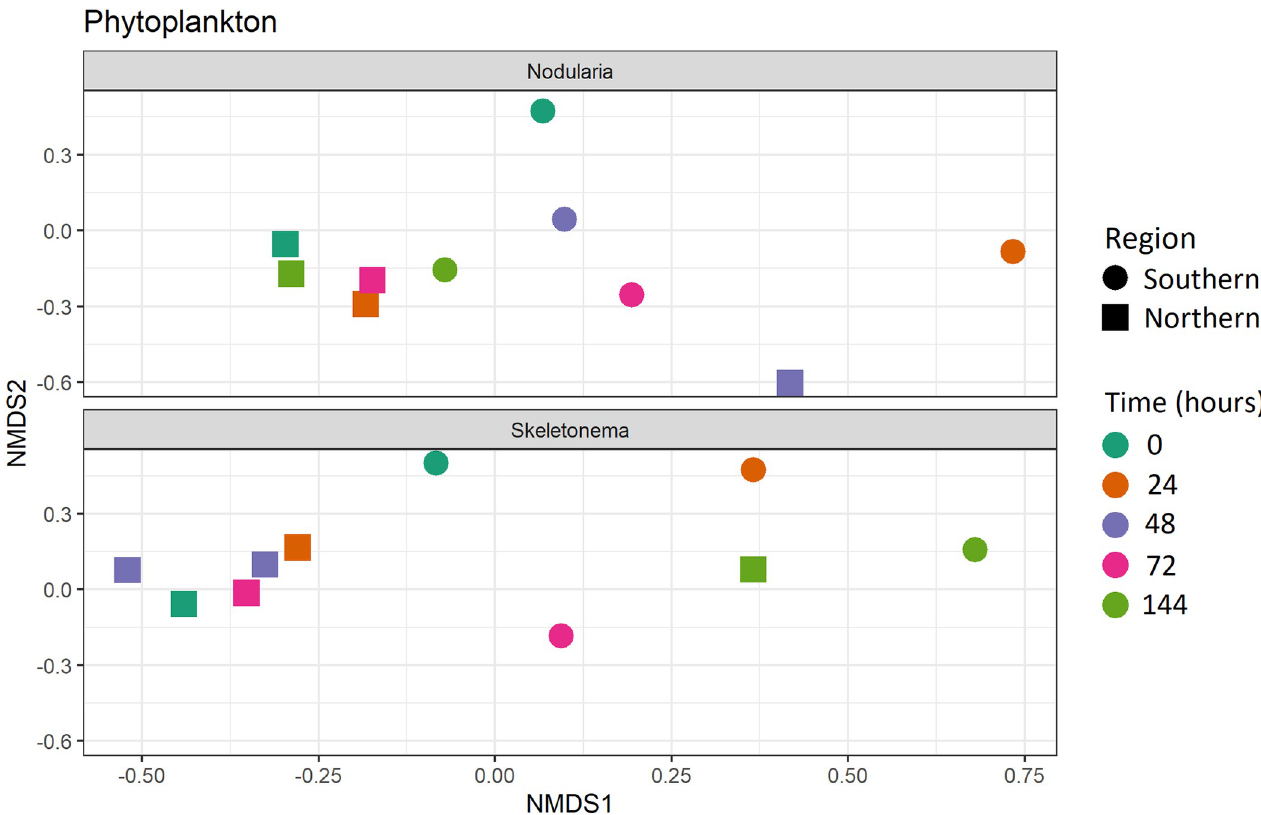
Fig 4. Phytoplankton community consumed by Macoma balthica ordination. Non-metric multidimensional (NMDS) scaling based on the Bray-Curtis dissimilarity index of DNA 23S rRNA gene metabarcoding communities in guts of M . balthica found by phytoplankton fed (cyanobacteria Nodularia spumigena on top, diatom Skeletonema marinoi on bottom), with shapes showing region (circle southern Stockholm archipelago, square northern Stockholm archipelago), and sampling time point (stress = 0.16). For full NMDS see S3 Fig.